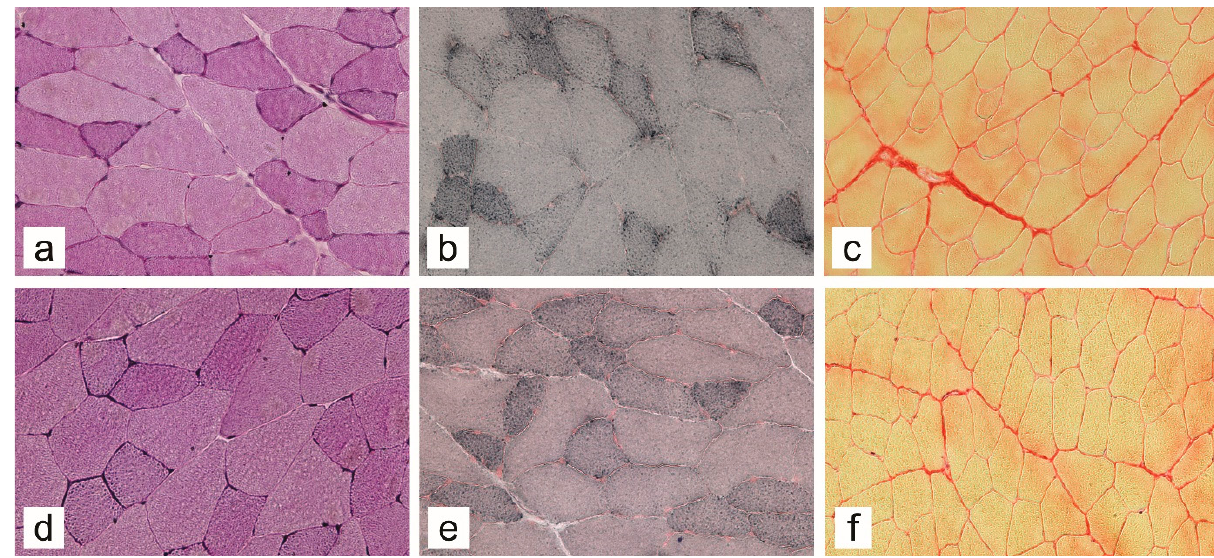
Figure 6 . Representative images of PAS (glycogen) ( a , d ), Sudan Black B (lipids) ( b , e ), and Sirius red (collagen) ( c , f ), stained transverse sections of gluteus maximus ( a – c ) and gastrocnemius ( d – f ) muscles of 13-week-old non-diabetic mice. Magnification: 200×.